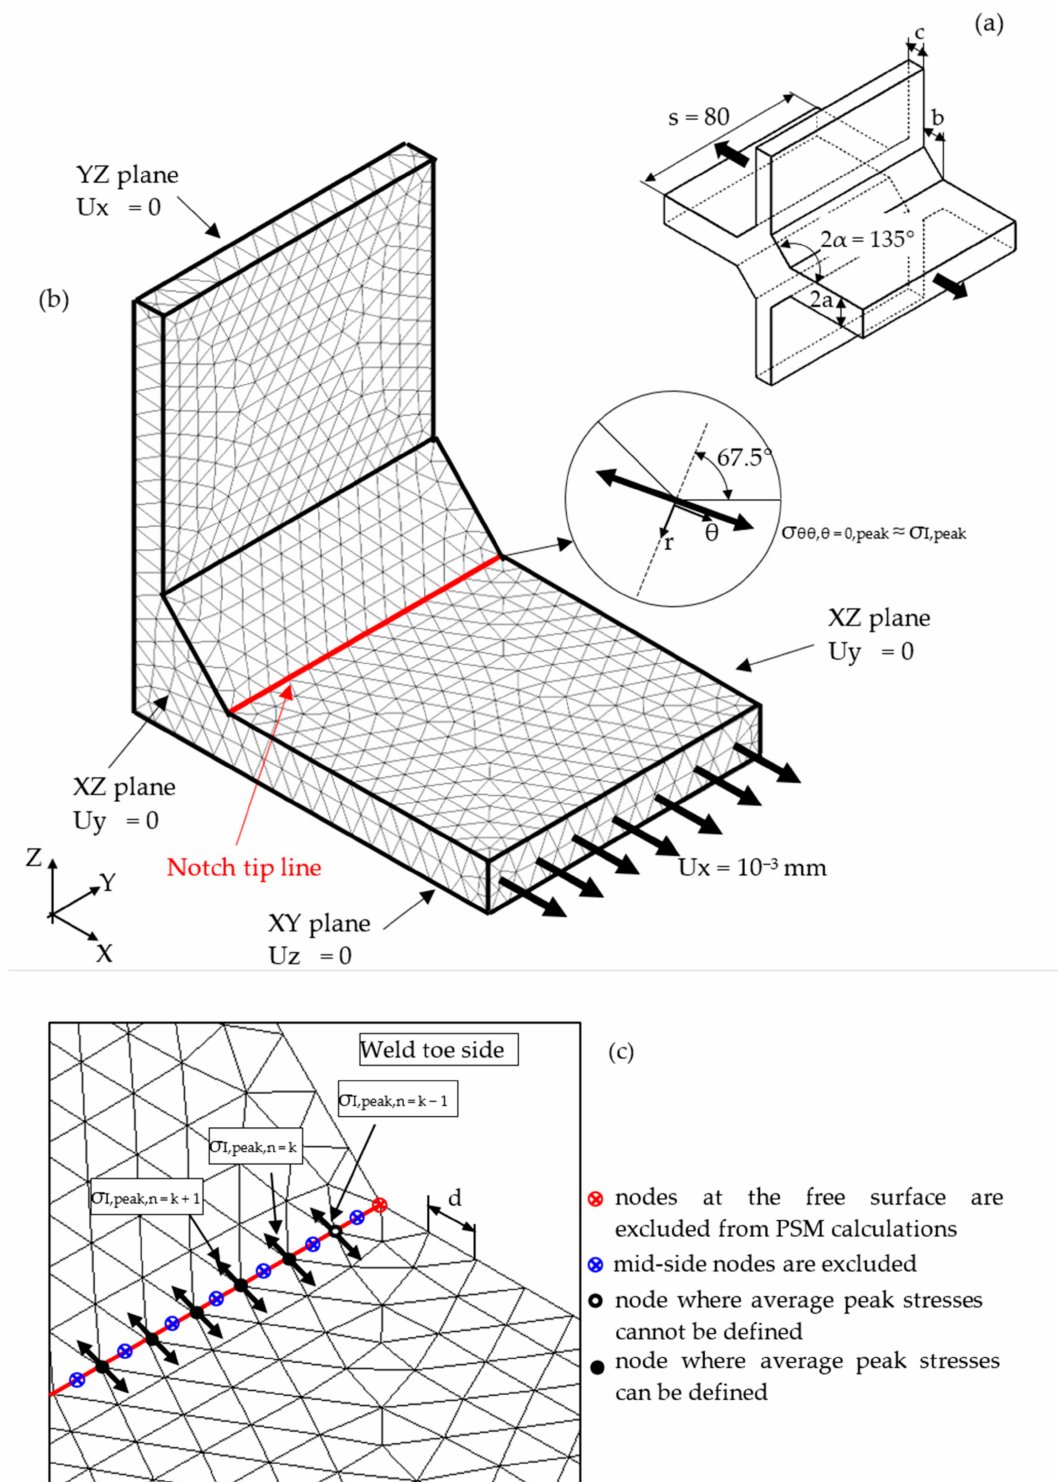
Figure 2. FE model to apply the Peak Stress Method (PSM) according to Equation (2) at the weld toe of a full-penetration cruciform welded joint ( a ) under axial loading using 3D 10-node tetra elements ( b ). Considered case: 2a = 13 mm, b = 10 mm, c = 8 mm, and 2 α = 135 ◦ . Free mesh pattern of 10-node tetra elements of Ansys ® code with element size d = 3 mm. Applied load: displacement U x = 10 − 3 mm. ( c ) Nodes where peak stresses can be computed and adopted to estimate the